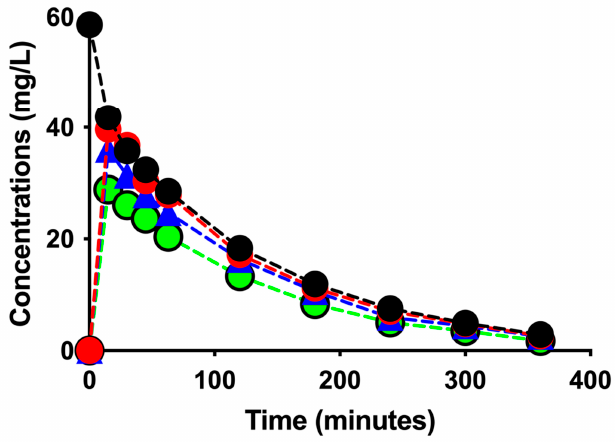
Figure 1. Time courses of vancomycin concentrations in the CC (black filled circles with dotted black line), inlet (red filled circles with dotted red line), outlet (blue filled triangles with dotted blue line), and instantaneous effluent ports (green filled circles with dotted green line) in the two sessions.